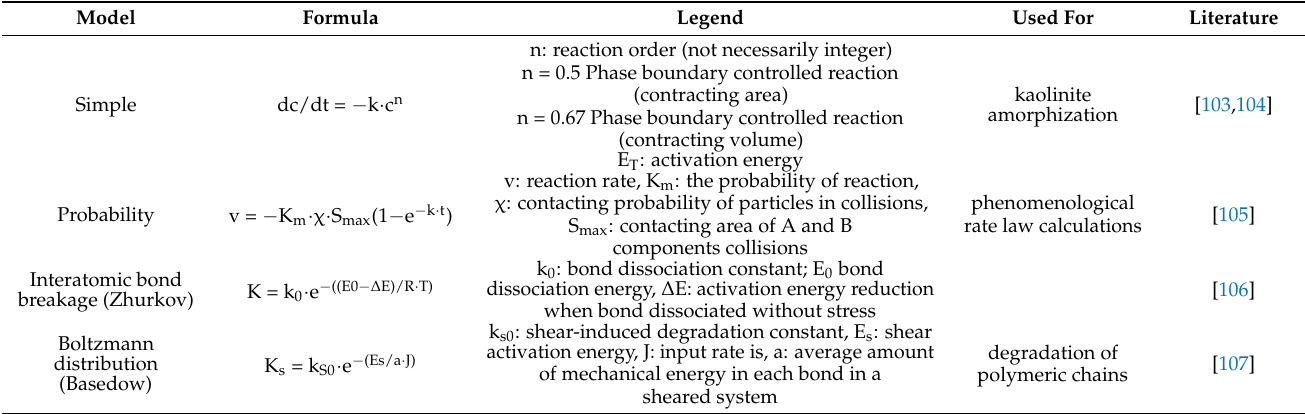
Table 1. Reaction-kinetics models of ball milling in the A + B → C reaction. Legend Used For